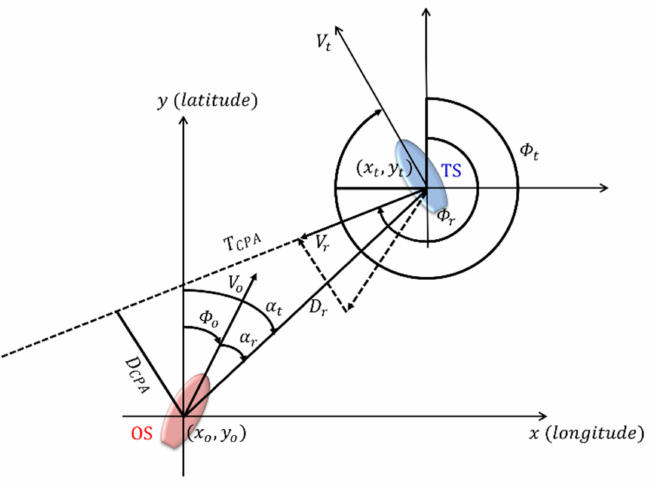
Figure 4. Geometry of collision of moving